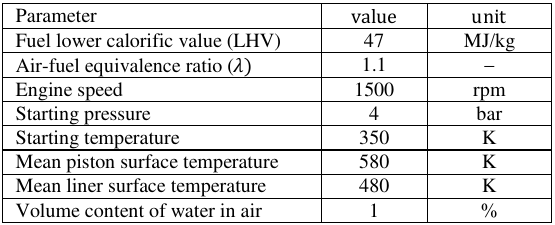
Table 10. Constant parameters for engine cycle simulations